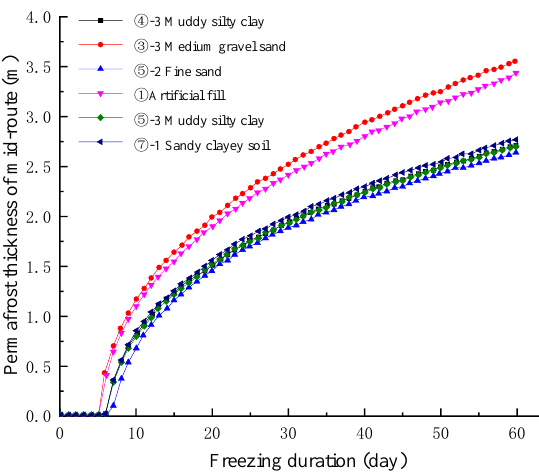
Figure 10. The thickness of frozen soil between jacking pipes. Table 9. The freezing duration required for the frozen soil thickness midline in different soil layers (day).